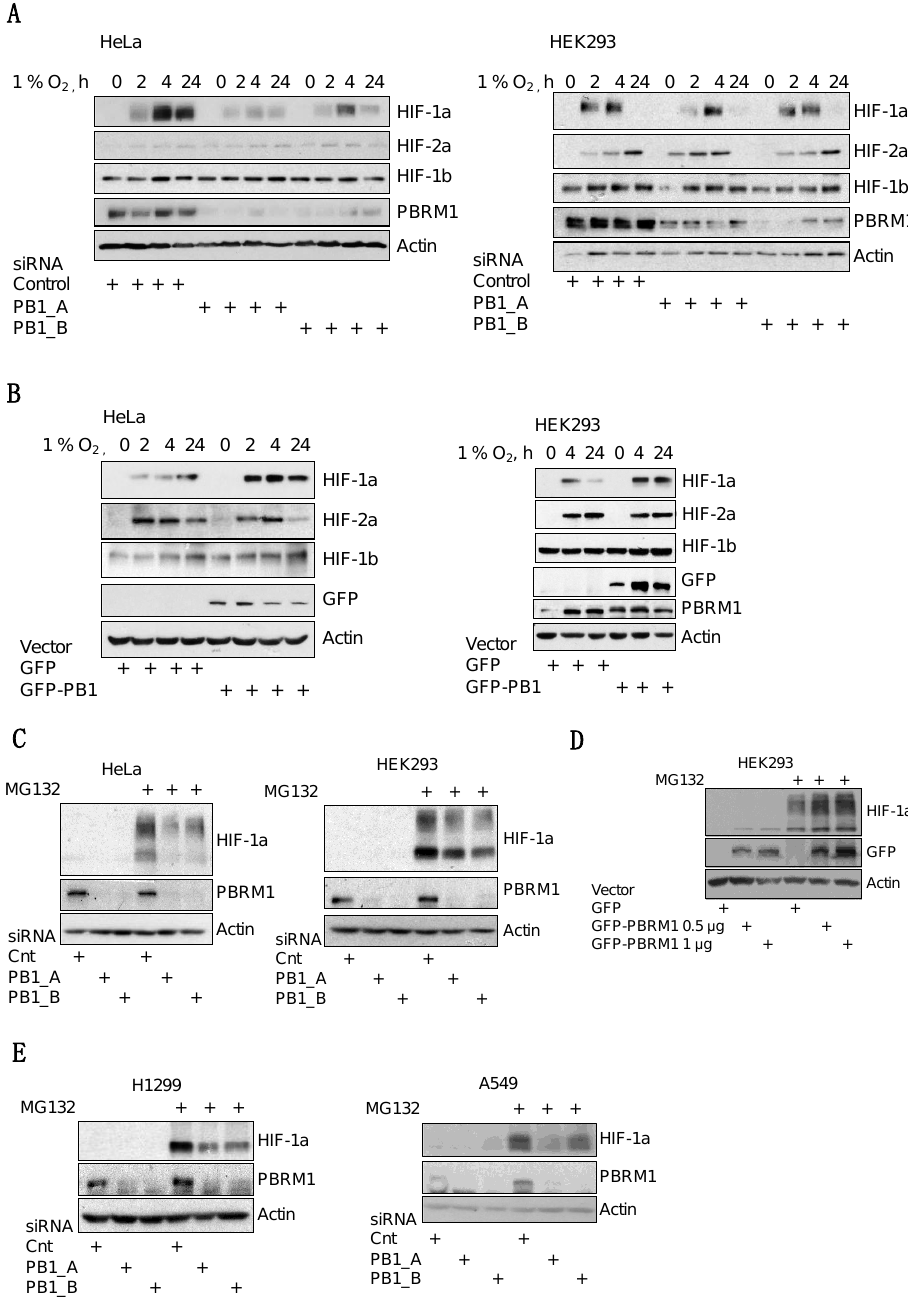
Figure 2. PBRM1 is required for HIF-1α protein levels independently of proteasomal degradation. ( A ) The HeLa and HEK293 cells were transfected for a total of 48 h with either control or PBRM1 (PB1) siRNAs before exposure to treatments with 1% O 2 of different duration, +, signifies specific treatment. Whole-cell lysates were analysed by Western blotting to assess HIF isoform protein levels. ( B ) The HeLa and HEK293 cells were transfected with 1 µg of either the GFP empty vector or a plasmid containing GFP-PBRM1. The cells were then exposed to 1% O 2 for treatments of different duration. Whole-cell lysates were analysed by Western blotting to assess HIF isoform protein levels. ( C ) The HeLa and HEK293 cell lines were transfected with control or PBRM1 siRNAs, then treated with DMSO or MG132 for 3 h before lysis. Whole-cell lysates were analysed by Western blotting to assess HIF-1 α protein levels. ( D ) The HEK293 cells were transfected with 1 µ g of either the GFP empty vector or increasing amounts of a plasmid containing GFP-PBRM1. The cells were then treated with DMSO or MG132 for 3 h before lysis. Whole-cell lysates were analysed by Western blotting to assess HIF-1 α protein levels. ( E ) The H1299 and A549 cells were transfected with control or PBRM1 siRNAs, then treated with DMSO or MG132 for 3 h before lysis. Whole-cell lysates were analysed by Western blotting to assess HIF-1 α protein